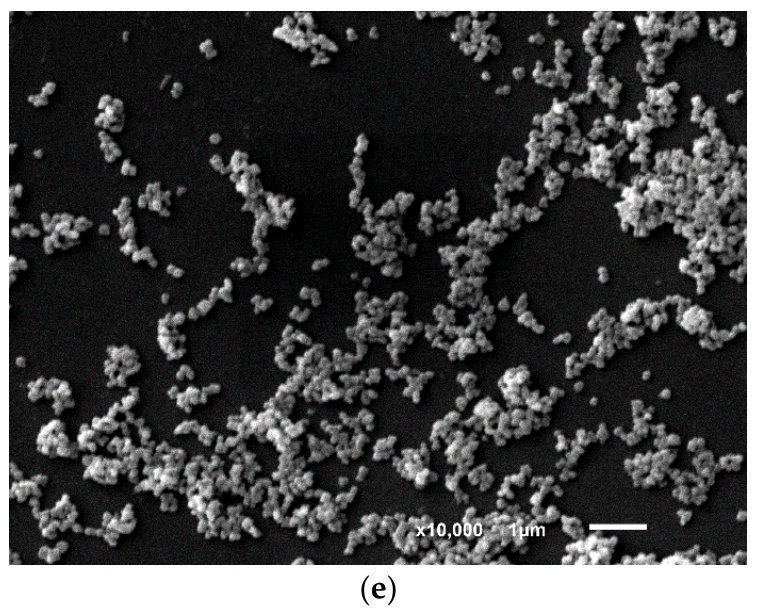
Figure 3. Scanning electron microscopy (SEM) images of zirconia particles ball-milled for ( a ) 0 h (as-received), ( b ) 1 h (coarse), ( c ) 4 h (intermediate), ( d ) 8 h (fine), and ( e ) 24 h (fine).